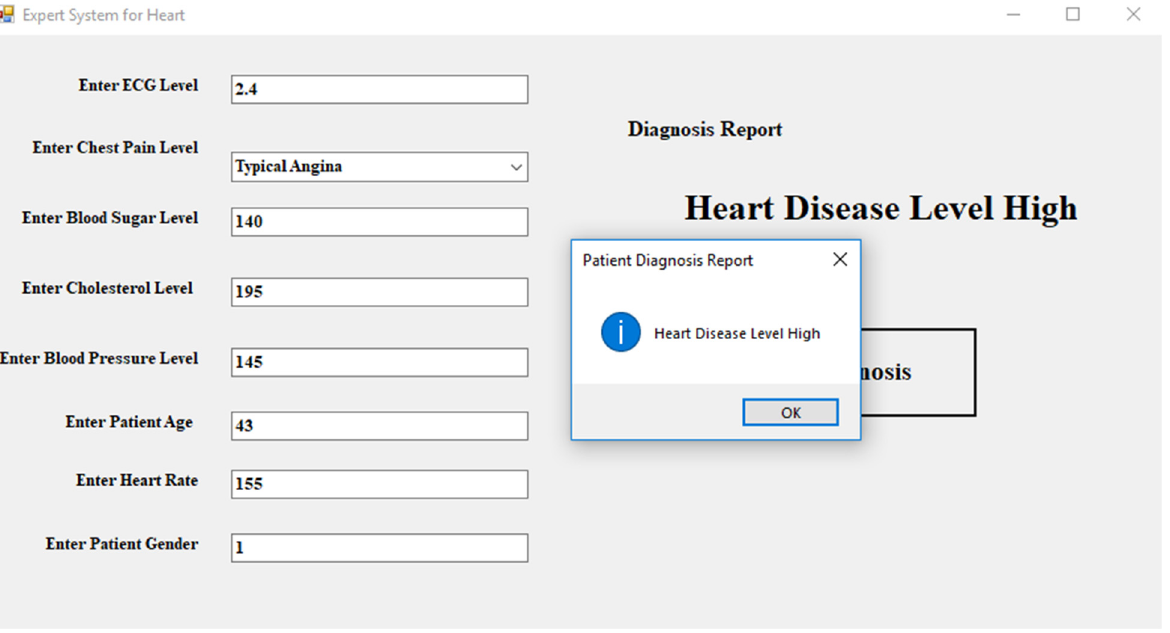
Figure 12. ECG 2.4, Chest Pain Typical Angina, Sugar 140, Cholesterol 195, BP 145, Age 43, Heart Rate 155 and Gender Male, output system is “High”.